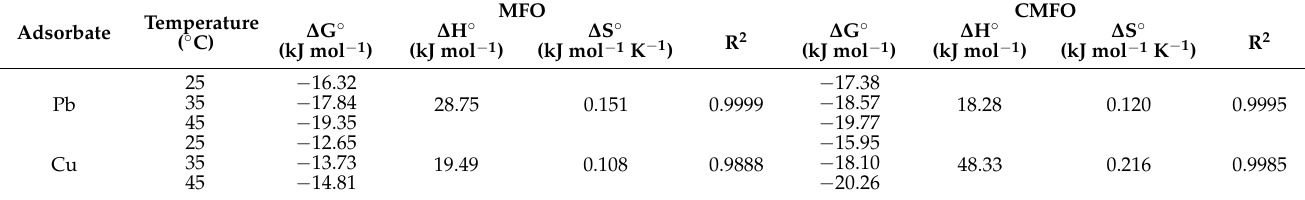
Table 2. Thermodynamic parameters on the adsorption capacity of CMFO and